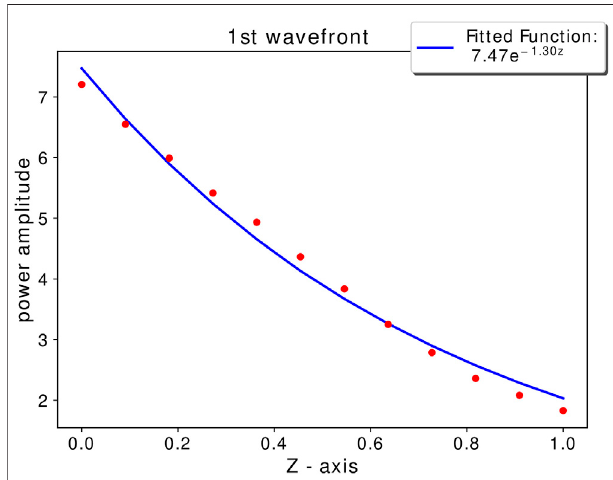
Figure 4 , showing the damping length of different widths for